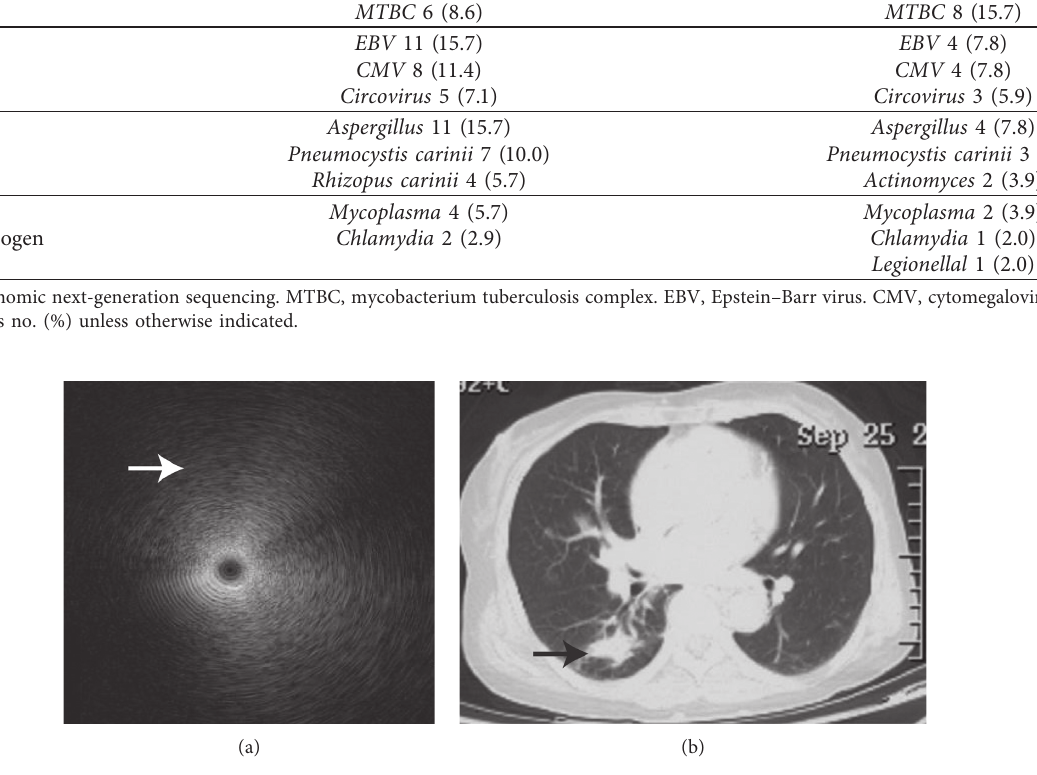
Figure 1: Homogenous internal echoes. Image of a 72-year-old woman with a peripheral consolidation lesion over the right lower lung lobe by chest radiography ((b) black arrow) with parrot chlamydia pneumonia identified by mNGS. EBUS demonstrated homogeneous internal echoes without margins (a). The particles displayed a formation of concentric circles around the echo probe, and entire images exhibited a sense of gradation. The particles lengthened to form a very short arc of the circumference, particularly in the outer part (white